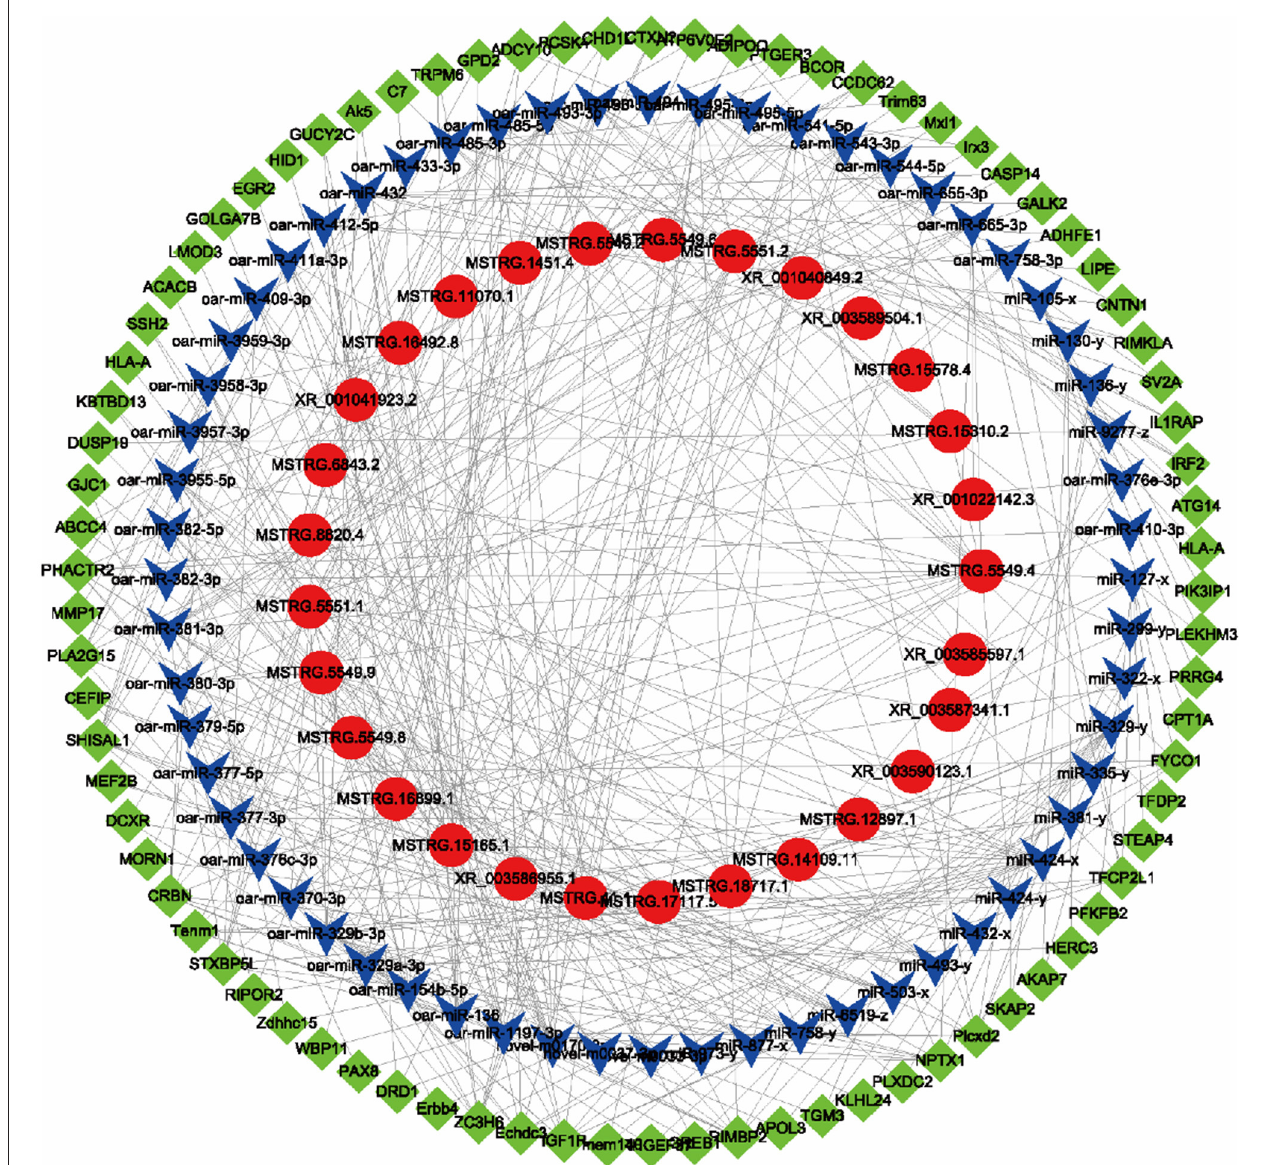
FIGURE 6 | The lncRNA-miRNA-mRNA ceRNA regulatory network related to fat and fatty acid metabolism in Tibetan sheep muscle. The red circle represents lncRNAs. Blue V represents miRNAs. Green diamonds represent mRNAs.